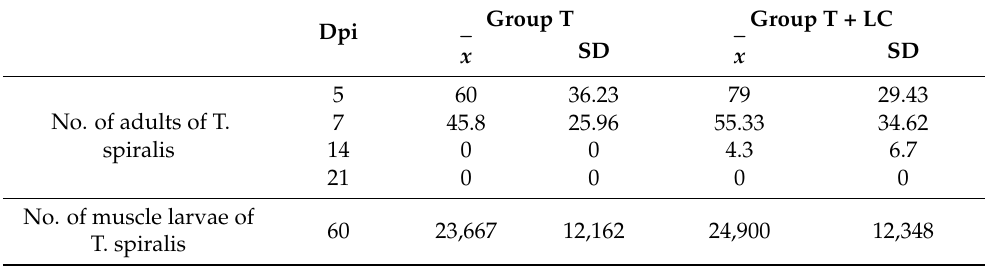
Table 10. Effect of LC on the number of Trichinella spiralis adults in the intestine and the number of larvae in the muscles of the infected